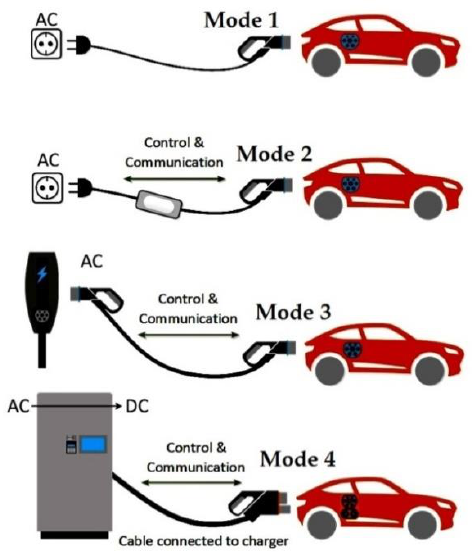
Figure 4. IEC 61851-1 charging modes.